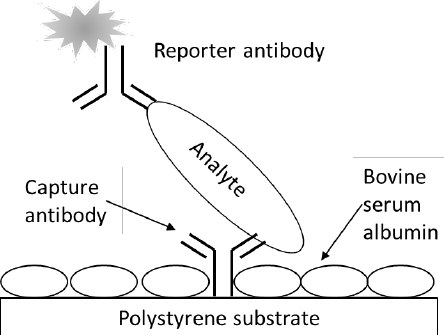
Figure 1. Fluorescence sandwich immunoassay schematic. Represented are analyte (e.g., bacterial cell or proteinaceous toxin) bound at a microarrayed spot of capture antibodies printing on the bottom of a well of a multiwell, black-walled, clear-bottomed, polystyrene microtiter plate. The bare polystyrene was further blocked with BSA and following analyte capture, reporter antibodies, conjugated with fluorescent molecules, were used to sandwich and label the analyte prior to detection with laser-induced fluorescence scanning.